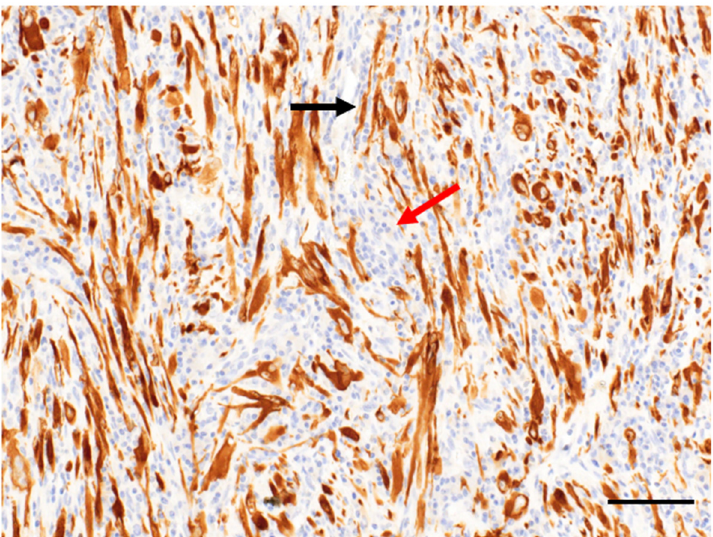
Figure 3. Immunostaining of an IMT with an antibody against anaplastic lymphoma kinase (ALK) and a peroxidase conjugated secondary antibody. Positive cells were stained with diaminobenzidine (black arrow). Nuclei were counterstained with hematoxylin (red arrow). Bar = 10 µm.